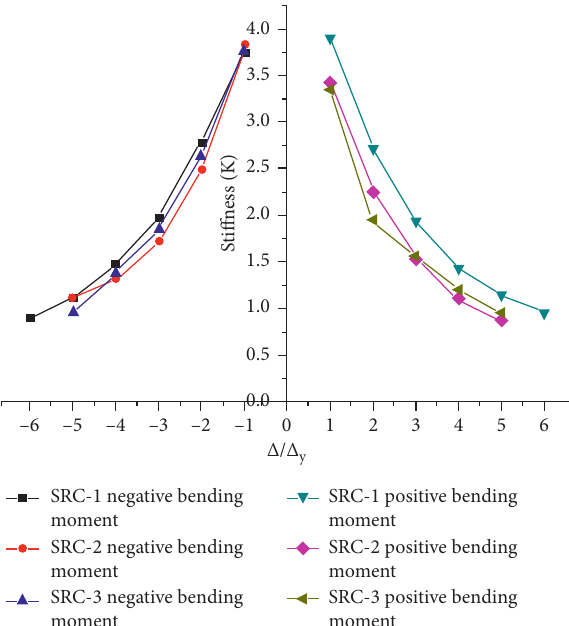
Figure 15: Stiffness degradation curves.